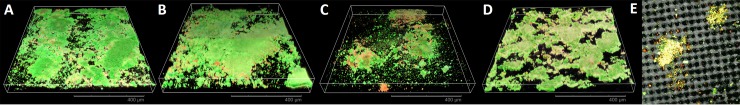
CLSM reconstructions of in vitro biofilm formation.A, B, C, and D, show 3D reconstructions of machined, grit-blasted, laser-treated and enamel surfaces. E shows a MIP of laser-treated surface, where the titanium surface was acquired on a separate channel and displayed in gray. In all reconstructions, viable microorganisms are stained in green, while dead microorganisms are stained in red. Compact biofilm structures with a prevalence of viable cells covering most of the machined, grit-blasted and enamel specimens can be observed. Laser-treated surfaces displayed less dense biofilm structures mainly constituted by microcolonies of approximately 200 μm diameter.